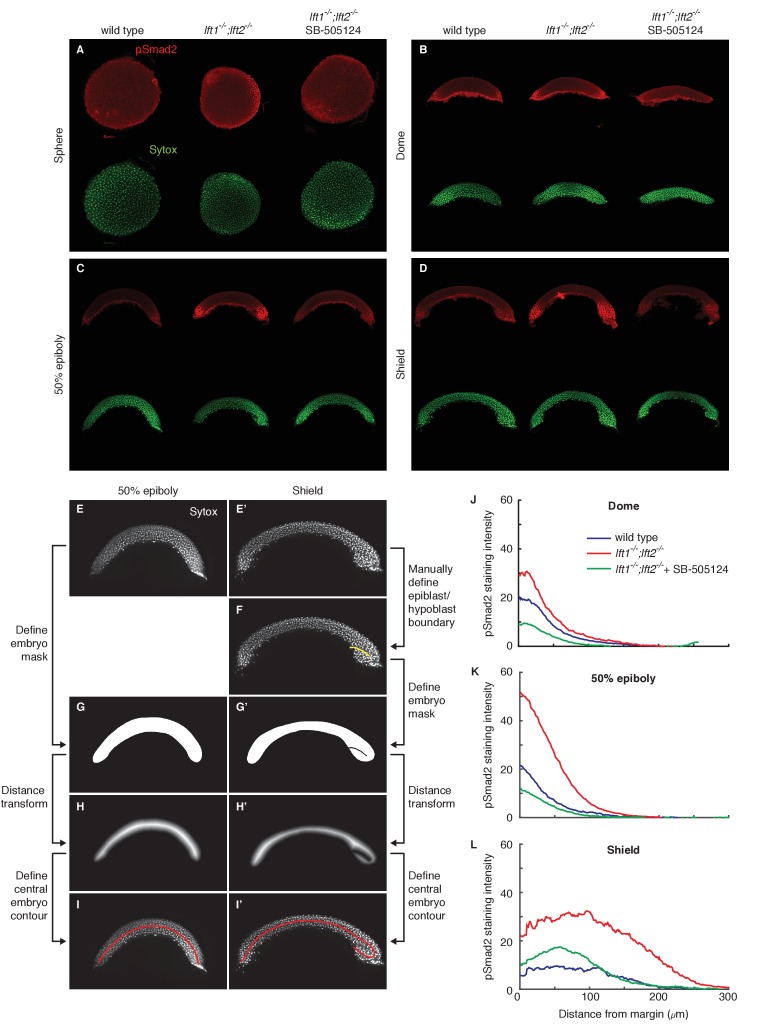
pSmad2 gradient quantification.pSmad2 gradients were visualized by α-pSmad2 immunofluorescence in wild type embryos, lft1-/-;lft2-/- mutant embryos, and lft1-/-;lft2-/- mutant embryos treated with 2 μM SB-505124 (Nodal inhibitor drug) starting at the 8 cell stage. (A–D) Representative maximum intensity projections for α-pSmad2 staining (red) and Sytox nuclear stain (green) in sphere (A), dome (B), 50% epiboly (C), and shield (D) stage embryos. Sphere stage embryos are animal pole views; all other stages are laterally oriented. For lateral images, projections were derived from the 10 slices surrounding the center of the embryo. (E–I’) Nodal signaling gradients were quantified by measuring nuclear pSmad2 immunofluorescence as a function of distance from the margin. To quantify gradients, individual nuclei were first identified, their distance from the embryo margin along a contour following the midline of the embryo cross-section was measured, the fluorescence intensity in each nucleus was determined, and finally intensity versus distance was plotted (see Materials and methods). The process of defining the contour for 50% epiboly (E,G,H,I) and shield (E’,F’,G’,H’,I’) stage embryos is illustrated here. (E,E’) Maximum intensity projections of Sytox green stacks used to identify nuclei and define embryo contour. The ten planes closest to the center of the embryo (five planes above and five below center) were used for quantification and calculation of the central contour. (F) For shield stage embryos, the boundary between the epiblast and involuting hypoblast was manually defined (yellow line). This boundary allowed the central contour to ‘wrap’ around the epiblast/hypoblast boundary at the embryonic shield. (G,G’) A minimal mask containing all segmented nuclei was defined. For shield stage embryos, pixels corresponding to the hypoblast/epiblast boundary were set to zero. (H,H’) To identify an approximate embryo midline, the distance transform of the inverse of the embryo mask (panels G,G’) was calculated. In this new representation, pixels within the mask that are the farthest from the mask boundary (i.e. pixels along its midline) have the highest values. (I,I’) The central contour of each embryo was defined by stepping from one margin to the other along the central maxima of the distance transform. The final contours used for gradient quantification are shown in red. (J–L) pSmad2 gradients are plotted for dome (J), 50% epiboly (K), and shield stages (L). Gradients in lft1-/-;lft2-/- mutants (red) have higher amplitudes than wild type (blue) or drug-treated lft1-/-;lft2-/- mutant (green) gradients. Some images from (A), (C), and (D) are also used in Figure 2.